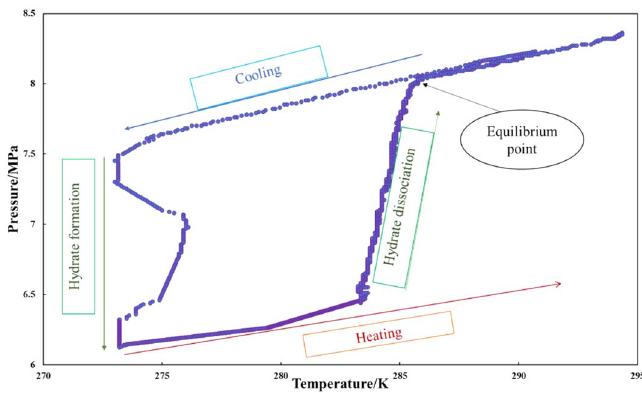
Figure 8. T-Cycle method to measure the equilibrium